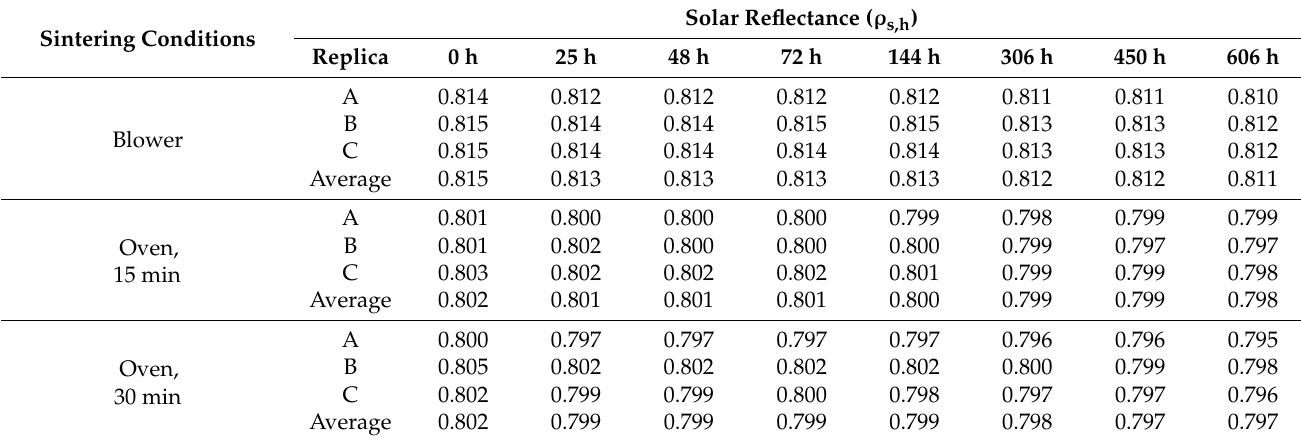
Table 6. Solar reflectance data after each degradation interval during the condensation test at 40 ◦ C. Data correspond to preheated Al/SiO 2 samples at different sintering conditions.